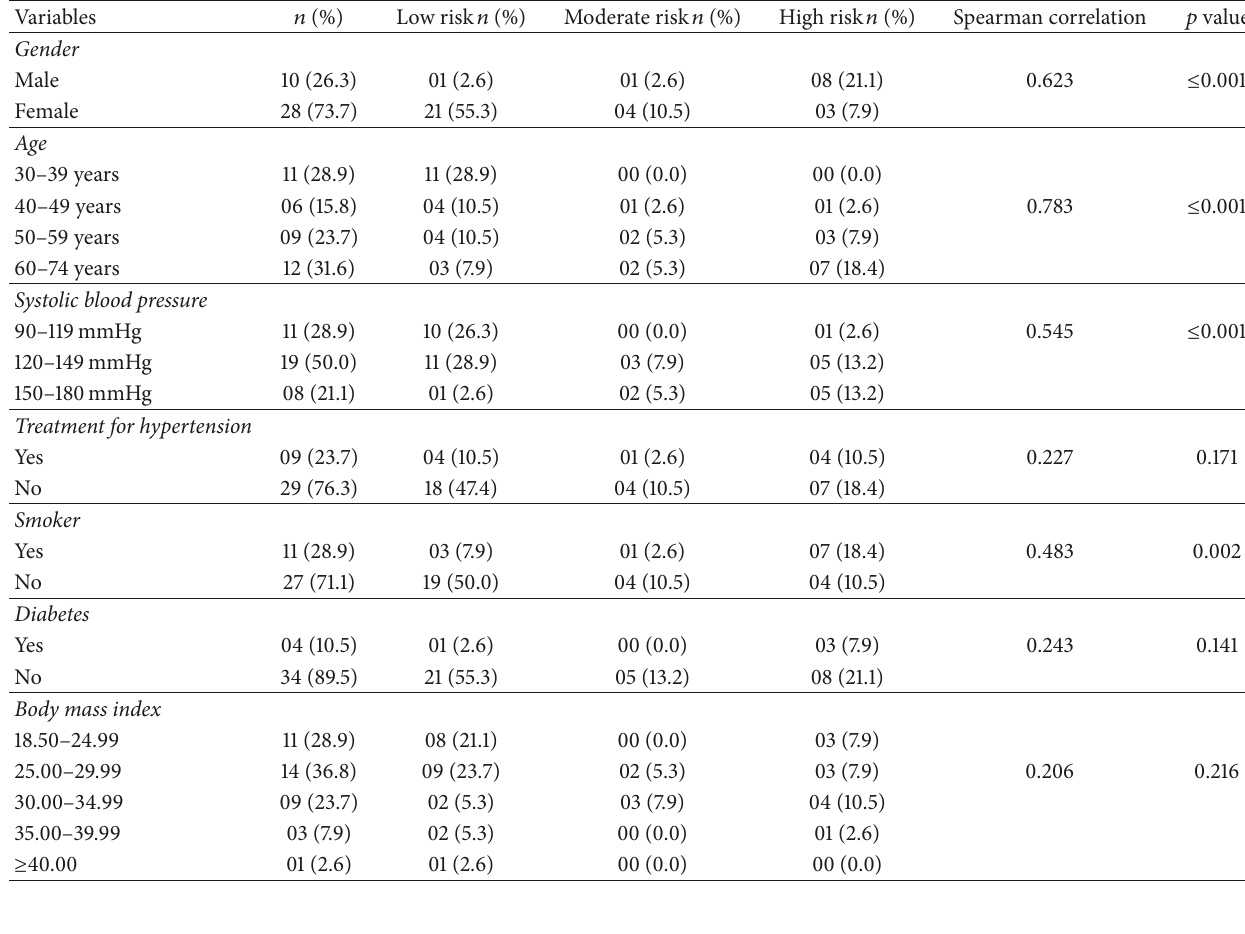
Table 2: Distribution of the variables of the global risk score of rural workers in the extreme south of Brazil ( 𝑛 = 38 ).